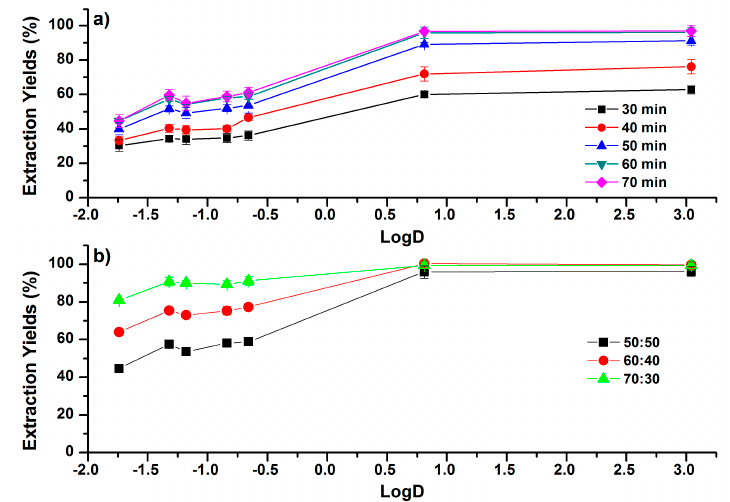
Figure 7. Correlations between EYs and the LogD (pH 7.4) values of phenolic compounds ( a ) under different cooling times in ACN–H 2 O mixture (50:50, v / v ); ( b ) under different concentrations of ACN in the ACN–H 2 O mixture (ACN:H 2 O, v / v ) with a cooling time of 60 min. Error bars present the standard deviation ( n = 3).